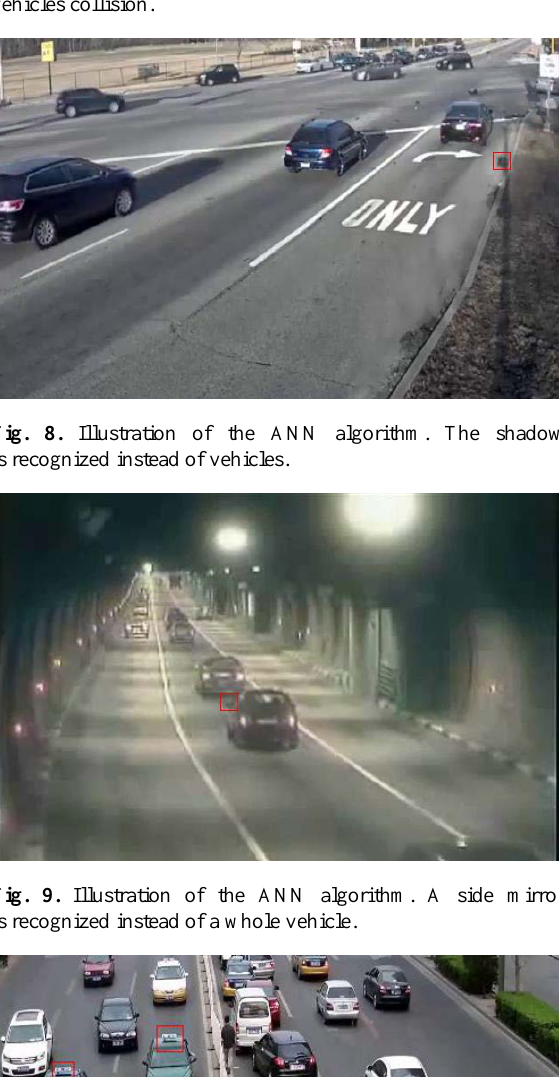
Fig. 6. Illustration of the ANN algorithm. Road defects are recognized (small squares) but not the vehicles.